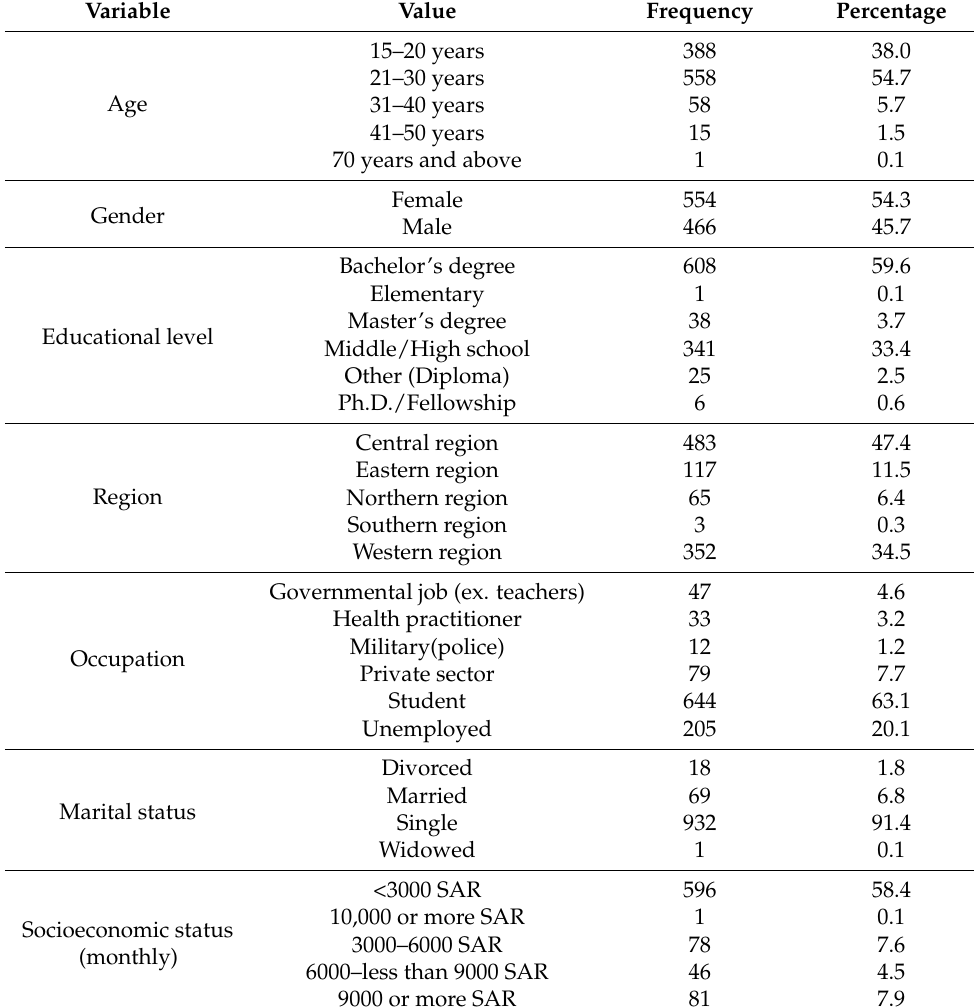
Table 1. Demographic profile of the study